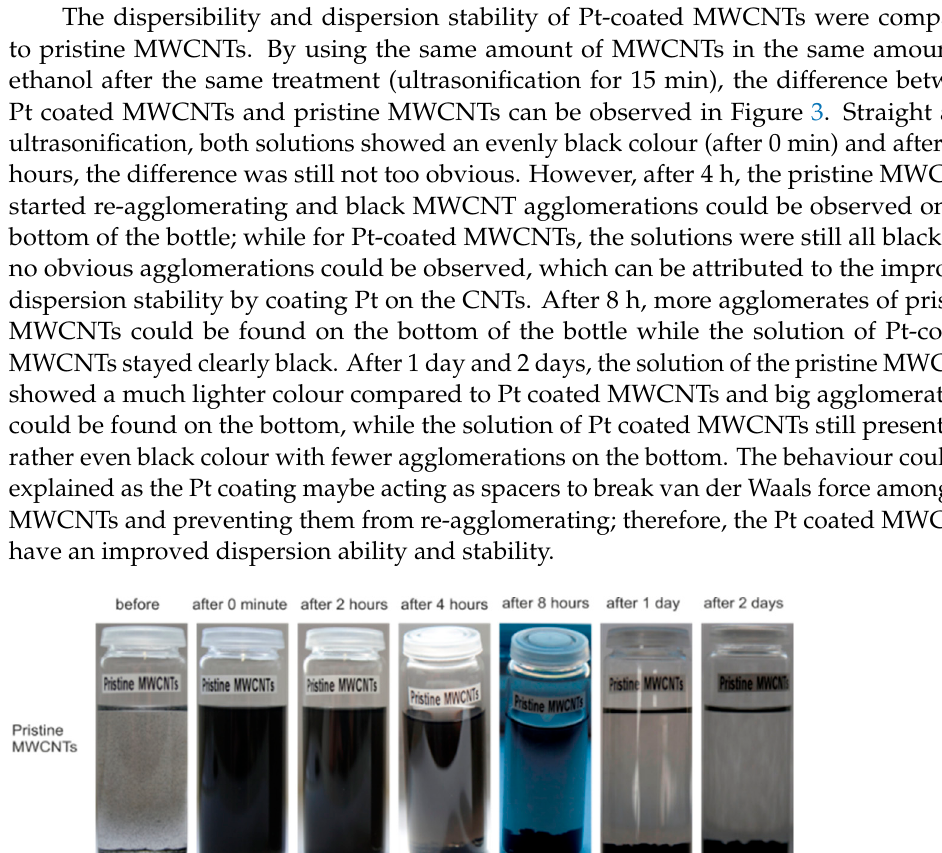
Figure 2. TEM image of overview of Pt coated MWCNTs (containing 30 wt% of Pt), containing Pt- coated MWCNTs and polymer residue with Pt clusters; ( a ) Overview TEM image of Pt coated MWCNTs; ( b ) TEM image of Pt coating on the surface of individual MWCNTs; ( c ) EDX analysis of selected area on the surface.